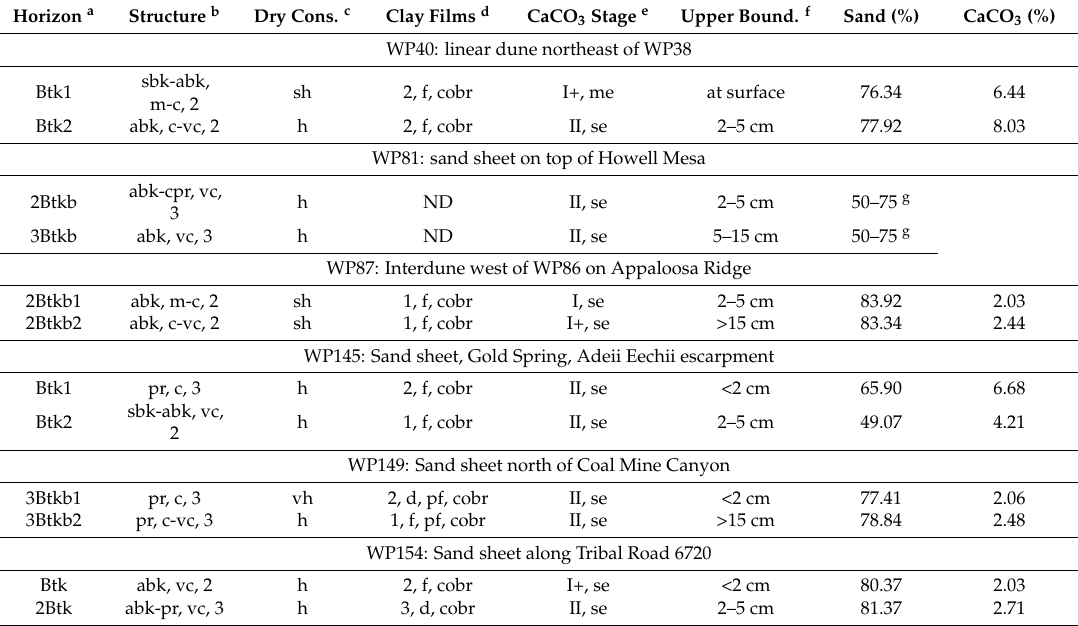
Table 6. Comparison of Btk horizons from Qe1 soil profiles in the study area.